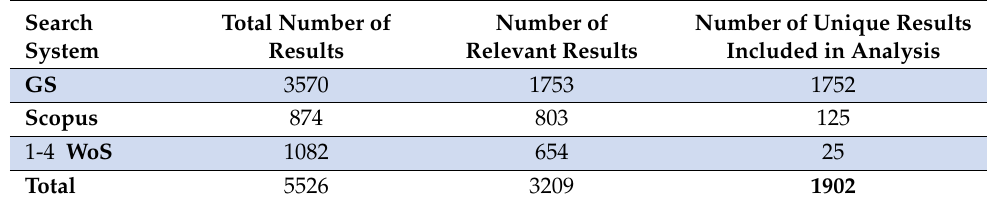
Table 1. Results of literature surveys for Aphidiinae studies using Google Scholar (GS), Scopus, and Web of Science (WoS). Total Number of Number of Number of Unique Results Results Relevant Results Included in